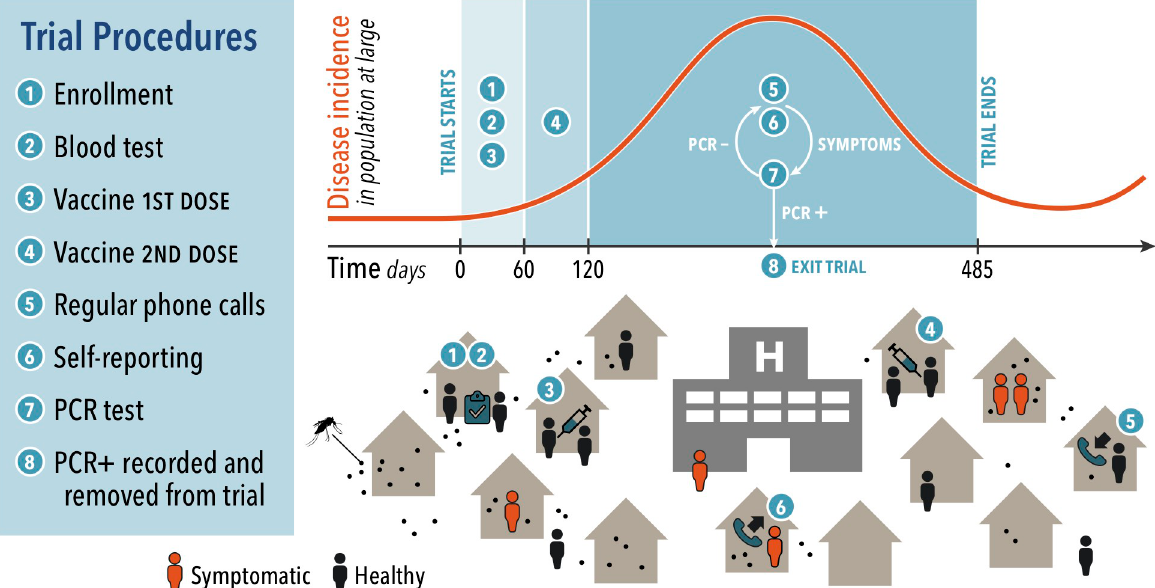
Fig 1. Modeling framework and trial procedures. DENV is transmitted by individual mosquitoes that are found indoors. Humans move daily to different types of locations within the city. Infectious mosquitoes transmit DENV through bites to individuals susceptible to the infecting serotype who are present at a location at the same time as mosquitoes seeking a blood meal. The trial consists of eight procedures listed in the figure. The top curve shows the timing of these procedures in reference to DENV transmission dynamics, and the bottom cartoon depicts each of the